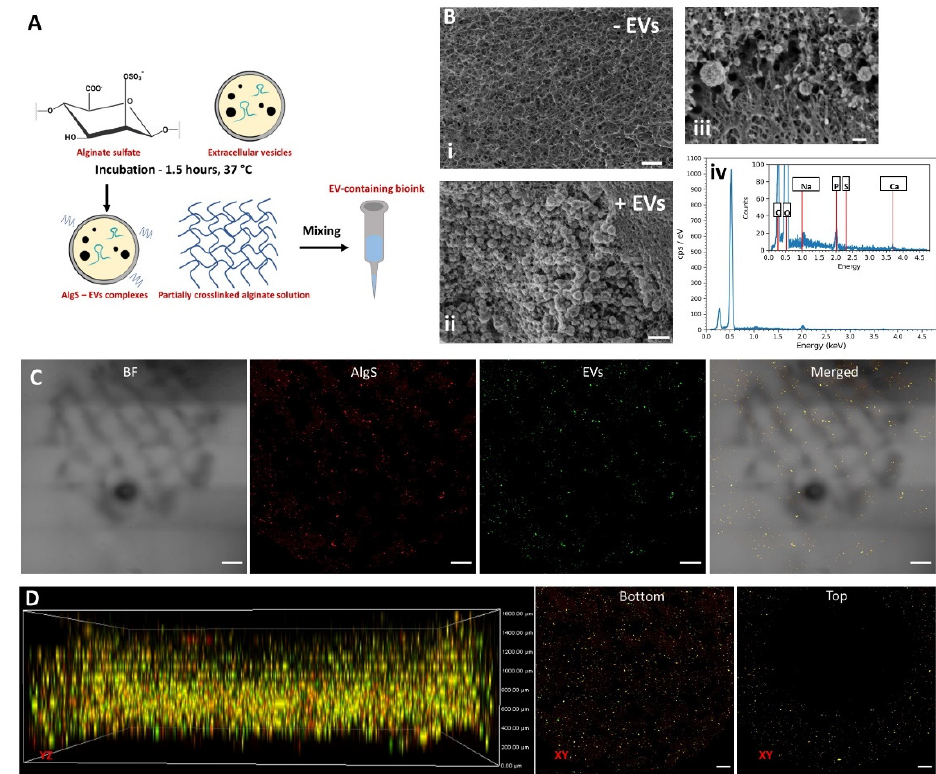
Figure 7. Three-dimensional bioprinting of AlgS-EV complexes. ( A ) A scheme describing the fabrication of alginate bioink with affinity bound EVs. Extracellular vesicles were reacted with alginate-sulfate and the bioconjugate solution was mixed with calcium cross-linked alginate solution. ( B ) Bioprinting of EVs within alginate bioink. Representative cryo-SEM images of alginate bioink constructs without EVs included (i) and with EV-AlgS complexes (ii). Scale bar: 200 nm. (iii) High magnification of alginate-containing 3D printed bioink. Scale bar: 100 nm. (iv) Representative EDX profile of EV-containing regions. ( C , D ) Confocal imaging of printed cardiac patches, demonstrating the locations of the different compartments. ( C ) Representative XY plane of EV-AlgS containing shell compartment. Scale bar: 500 µm. ( D ) 3D projections of printed constructs (left) and XY plane projections of bottom (middle) and top (right) layers of printed constructs. At the top layers, EV-AlgS complexes are located only at the outer shell, while at the lower, delivery compartment, EV-AlgS complexes are located within the entire printed area. CFSE-labeled EVs are in green, Cy5-labeled AlgS is in red. Scale bar: 500 µm.